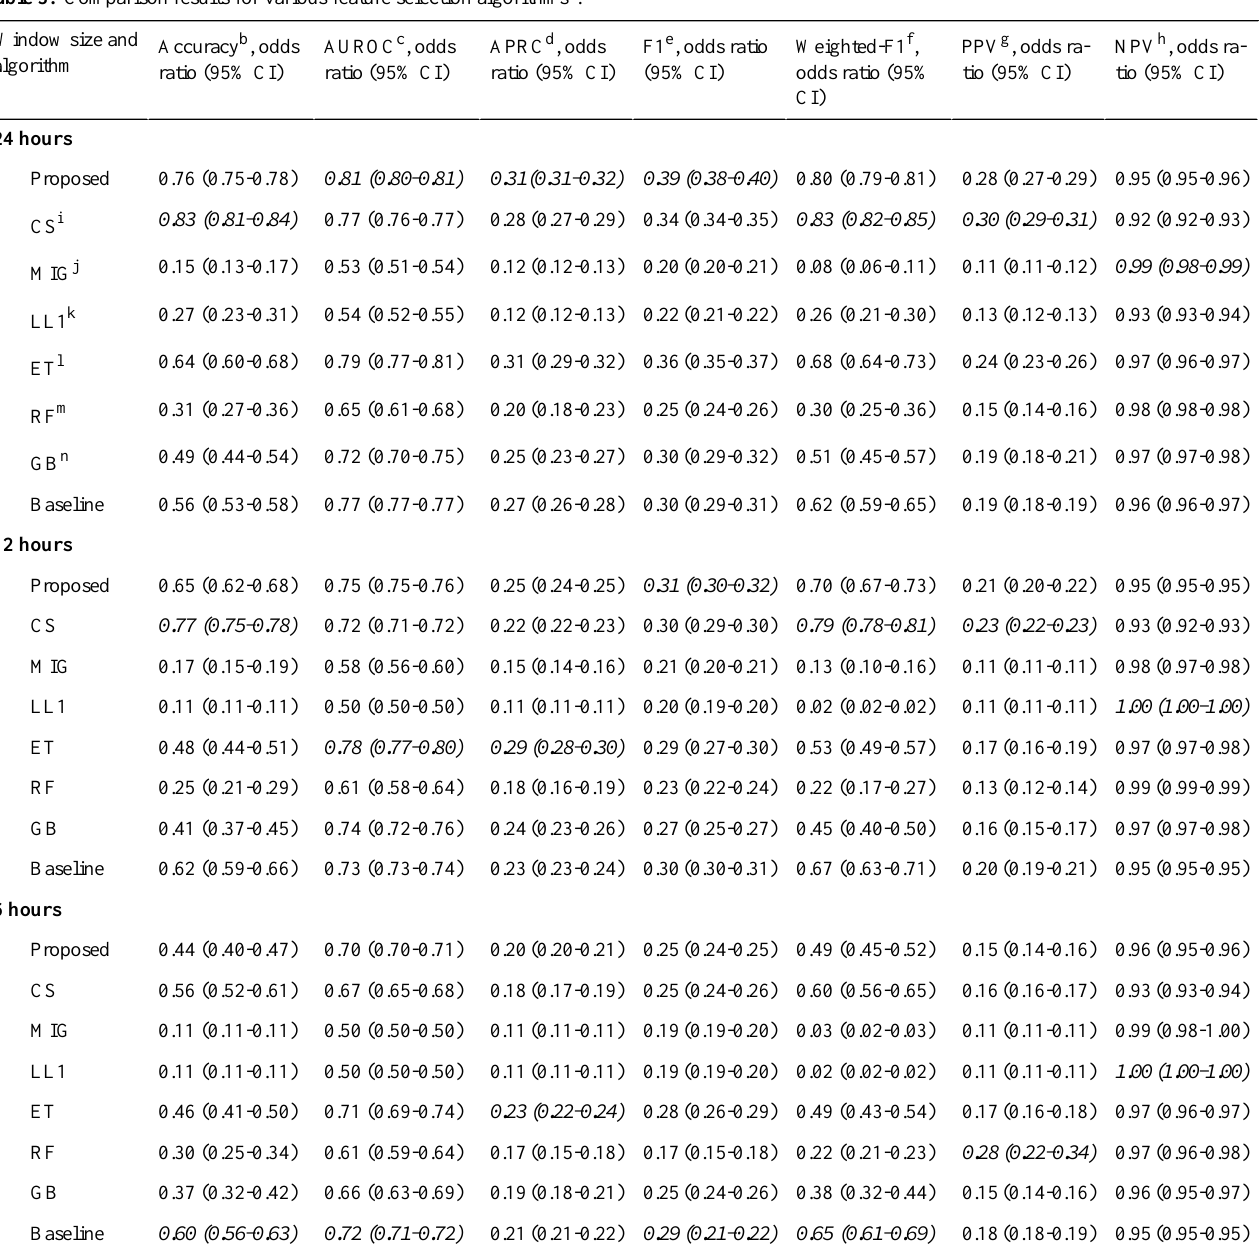
Table 3. Comparison results for various feature selection algorithms a